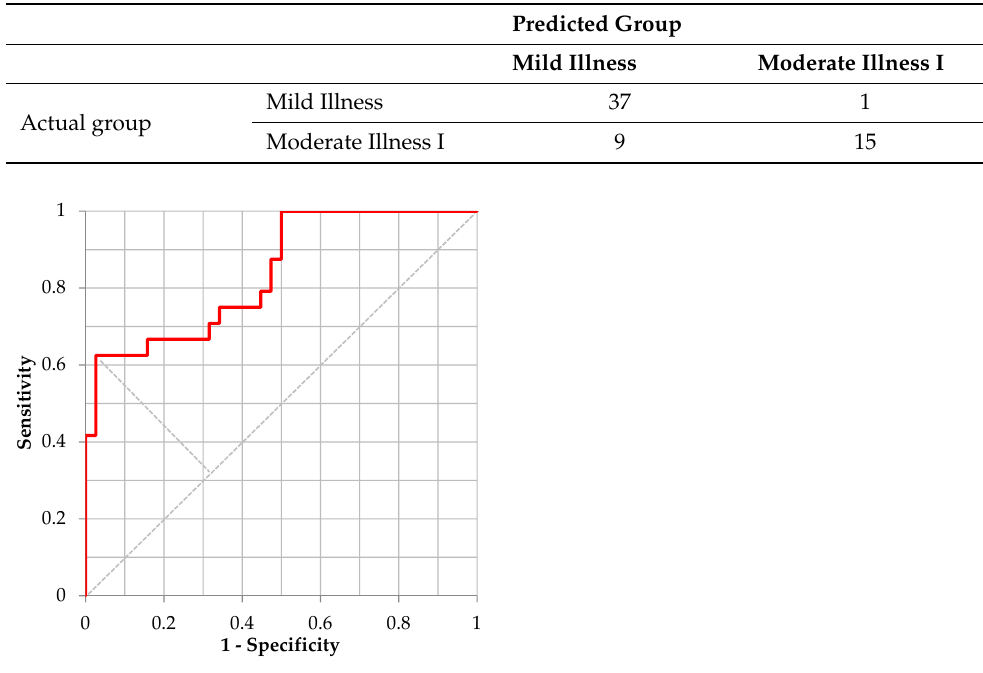
Figure 1. ROC curve distinguishing “Moderate Illness 1” using the learning model of /Ah/. Table 10. Confusion matrix of /Eh/.